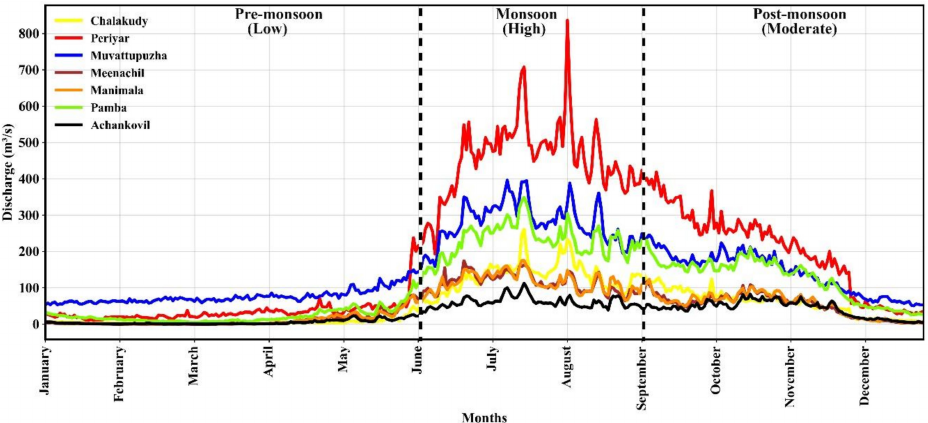
Figure 3. Daily climatological river discharges of the seven rivers at CE. Discharge data sourced from Central Water Commission, Government of India